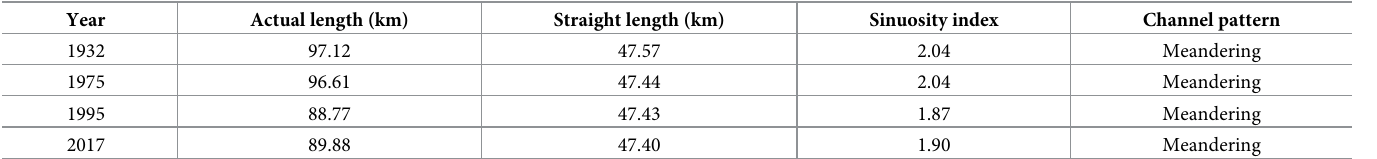
Table 3. Sinuosity index of River